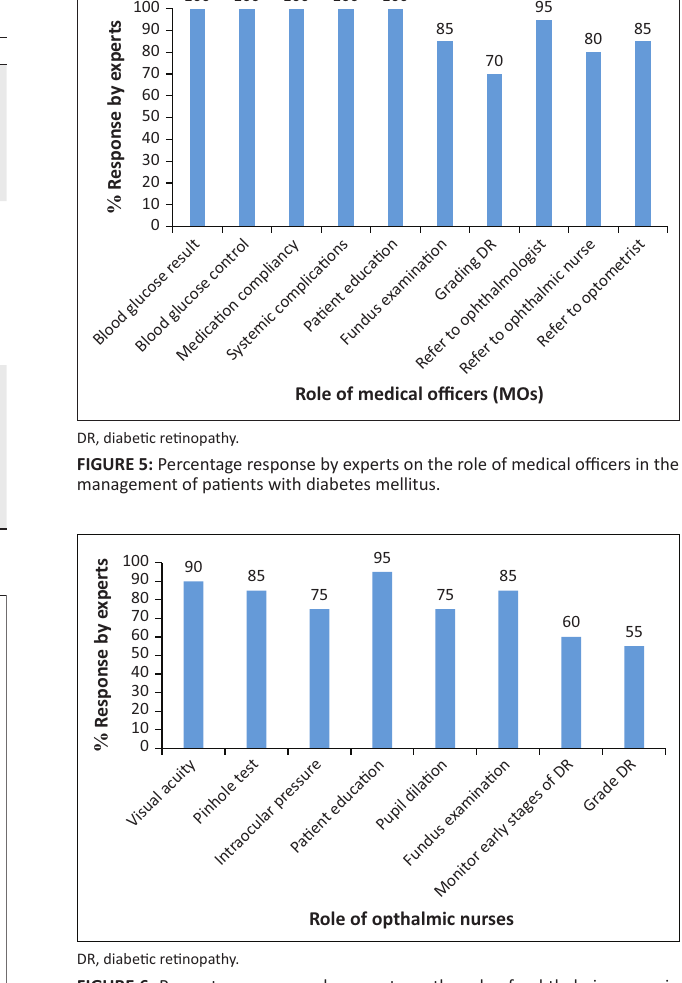
FIGURE 6: Percentage response by experts on the role of ophthalmic nurses in the management of patients with diabetes